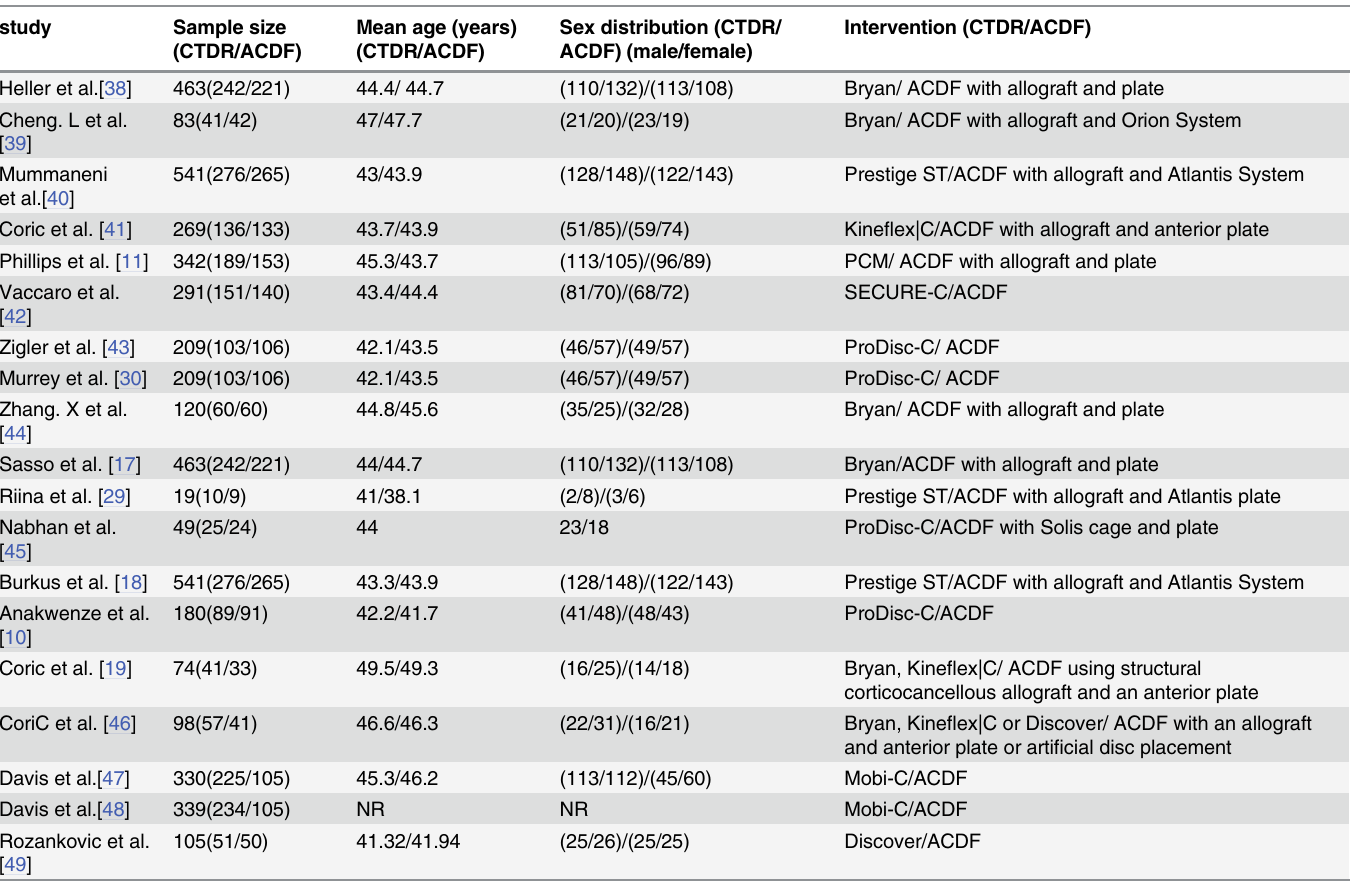
Table 1. Characteristics of the articles included in this